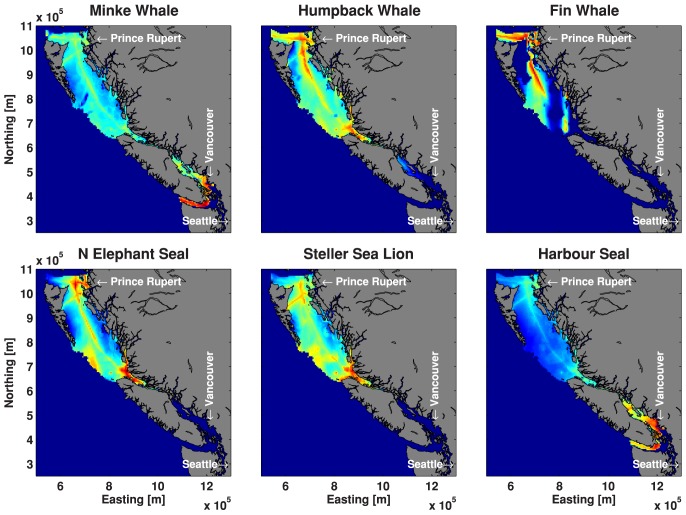
Map of ship noise and animal hotspots for baleen whales and pinnipeds.All color scales range from 0 (blue) to 1 (red), indicating least to highest risk.